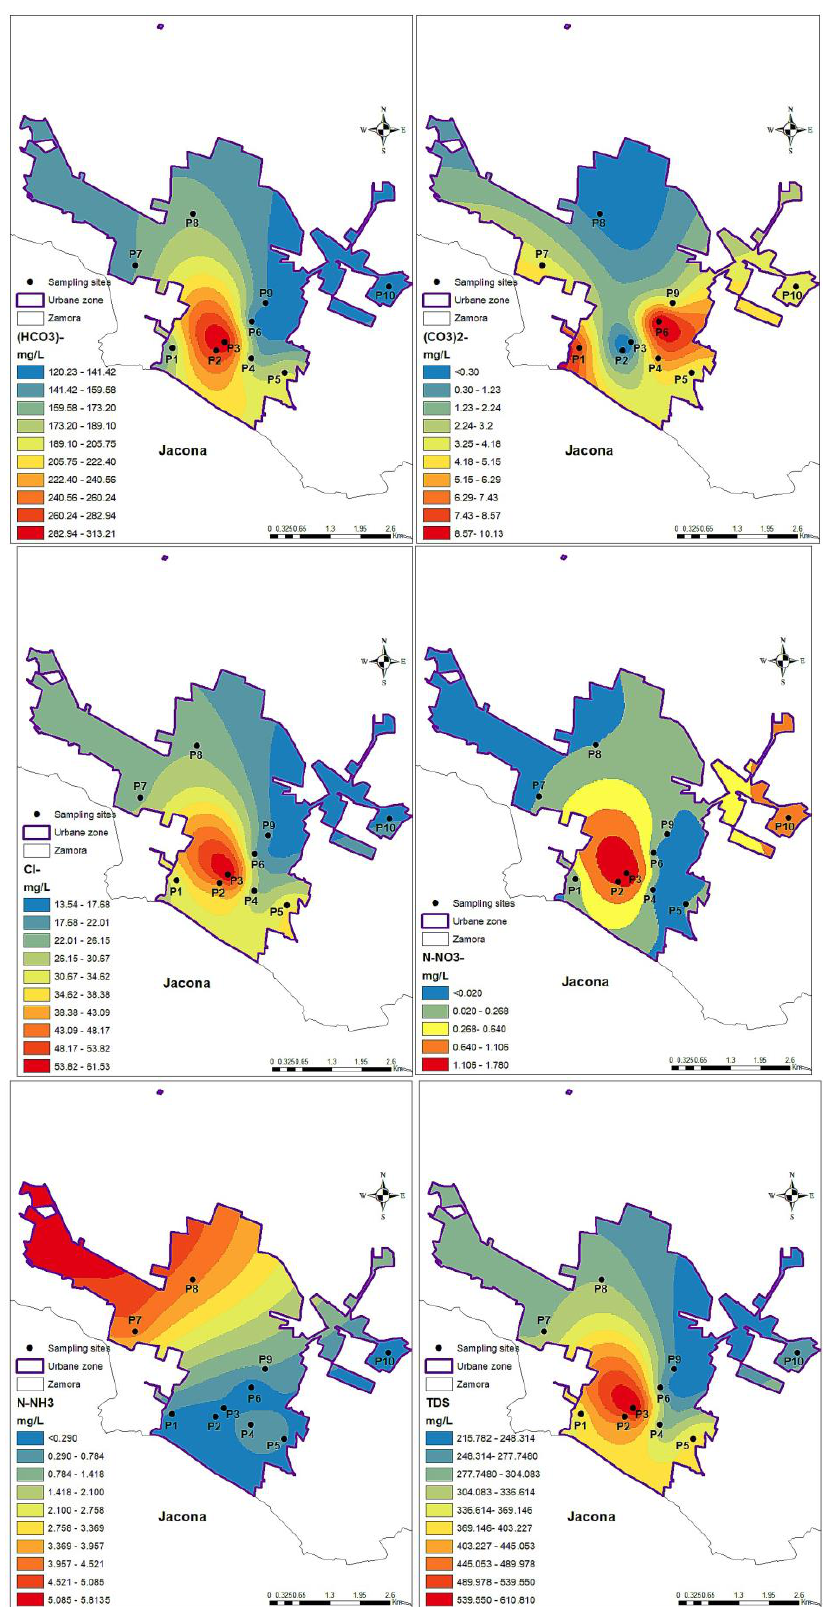
Figure 4. Distribution of the major ions content (mg / L): HCO 3 − , CO 3 2 − , Cl − , N-NO 3 − , N-NH 3 , and TDS in the studied zone.